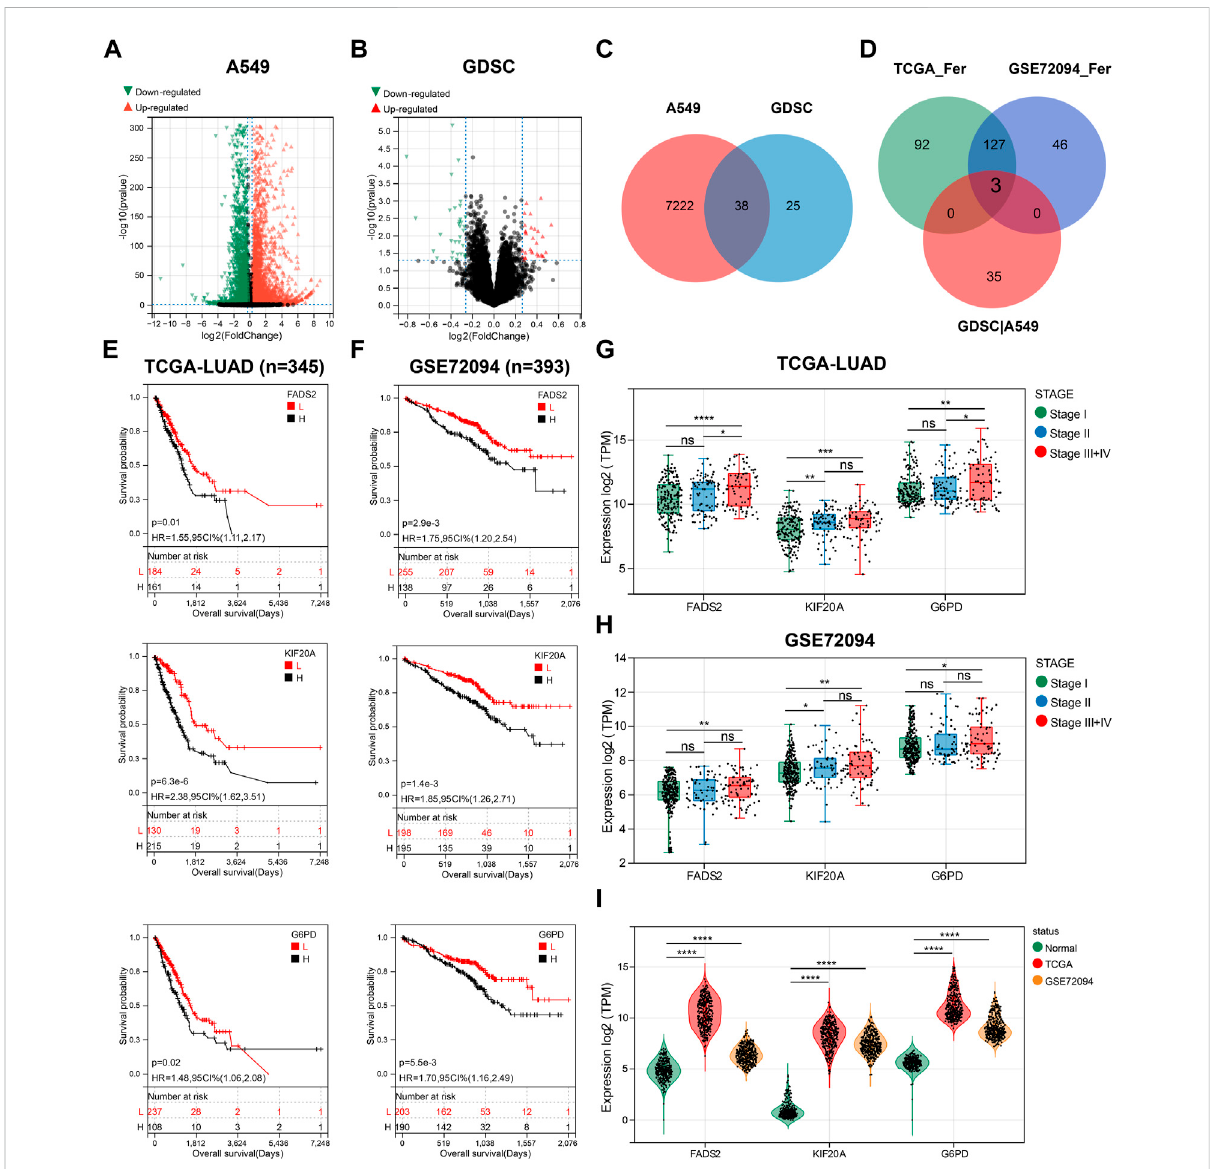
FIGURE 1 ThreeGEMresponse-relatedprognosticFGRswerescreened. (A) AvolcanoplotofdataobtainedbyRNA-seqcomparingA549cellsexposedto GEM and PBS for 48 h. (B) The volcano map showing the DEG between non-sensitive LUAD cells and GEM-sensitive LUAD cells. (C) Venn diagram depicting 38 screened GEM response-related genes. (D) Venn diagram to identify the common FRGs of GEM response-related genes, TCGA-LUAD prognostic FRGs and GES72094 prognostic FRGs. (E,F) K-M curves for OS of LUAD patients with high and low expression groups of the three candidate genes. (G,H) Box plots showed the expression of three candidate genes in different tumor staging samples. (I) Violin plots for comparing the expression levels of three candidate genes in normal lung tissue and LUAD samples. FRGs: ferroptosis-related genes; GEM: Gemcitabine; TCGA_Fer: prognostic FRGs in TCGA-LUAD; GSE72094_Fer: prognostic FRGs in GSE72094; GDSC|A549: the intersection genes of DEGs in GEM- treated A549 and GDSC databases; RNA-seq: RNA sequencing; LUAD: lung adenocarcinoma; K-M analysis: Kaplan-Meier analysis; OS: overall survival; HR: hazard ratio. * p < 0.05; ** p < 0.01; *** p < 0.001; **** p < 0.0001; ns p >